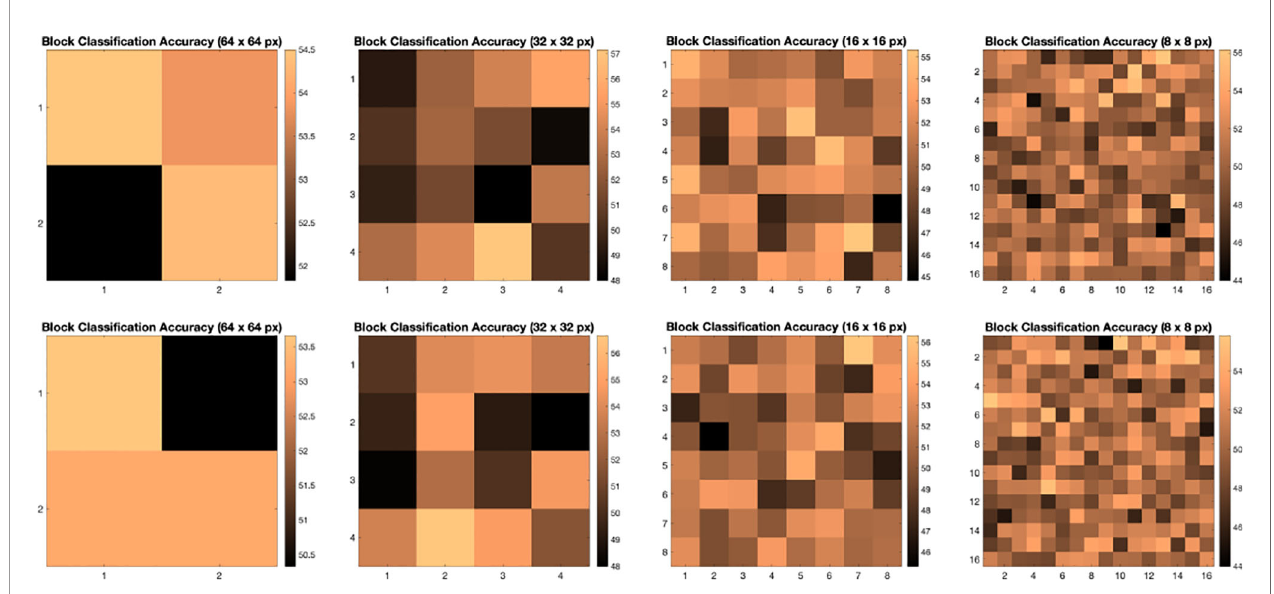
FIGURE 5 | Classi fi cation accuracy by block for 64 × 64, 32 × 32, 16 × 16, and 8 × 8 block experiments performed on the DDSM dataset for 10 fold CV (top row) and 30 fold CV (bottom row). The corresponding ensemble BBMAP-R and BBLL-R classi fi cation decision ACCs for 10-fold experiment examples are 57.33%, 53.67%, 56.17%, 54.67%, and 59.50%, 59.67%, 60.17%, 57.33% respectively for 64, 32, 16, and 8 blocks. The corresponding ensemble BBMAP-R and BBLL-R classi fi cation decision ACCs for 30-fold experiment examples are 54.67%, 57.00%, 57.67%, 54.50% and 55.00%, 61.33%, 59.50%, 58.83% respectively for 64, 32, 16, 8 blocks.